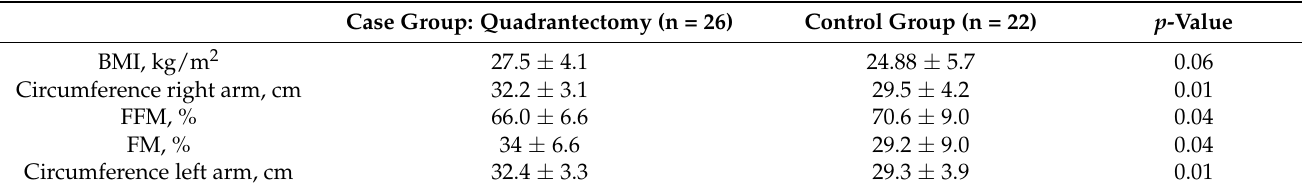
Table 1. Body composition of patients with quadrantectomy vs. control group.